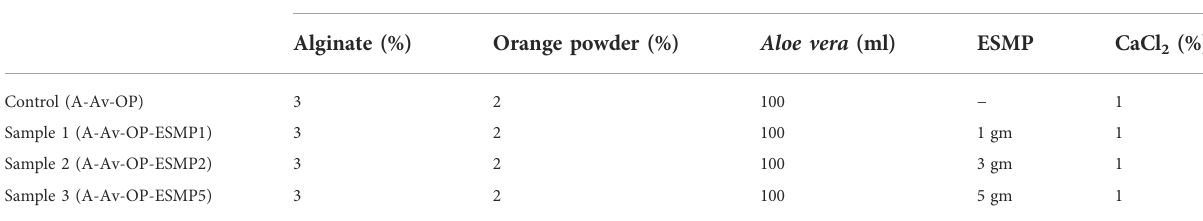
TABLE 1 Composition of the components used to fabricate the ESMP-loaded alginate (A), Aloe vera (Av), and orange peel (OP) extract bio-polymeric beads. Sample